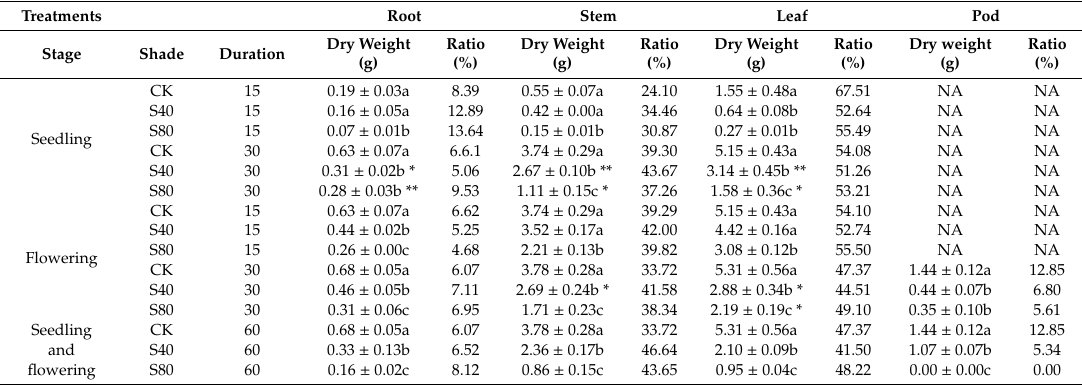
Table 6. E ff ects of shade stress on biomass of peanut